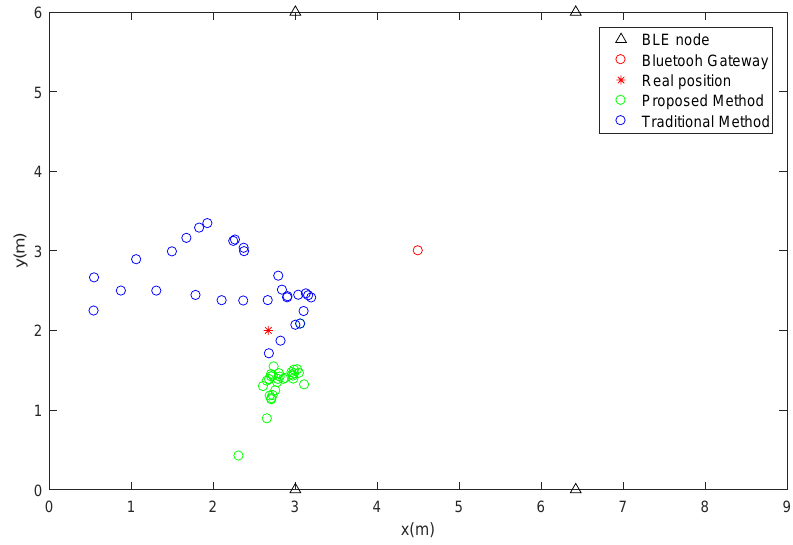
Figure 11. Comparison of the positioning results between the traditional and proposed